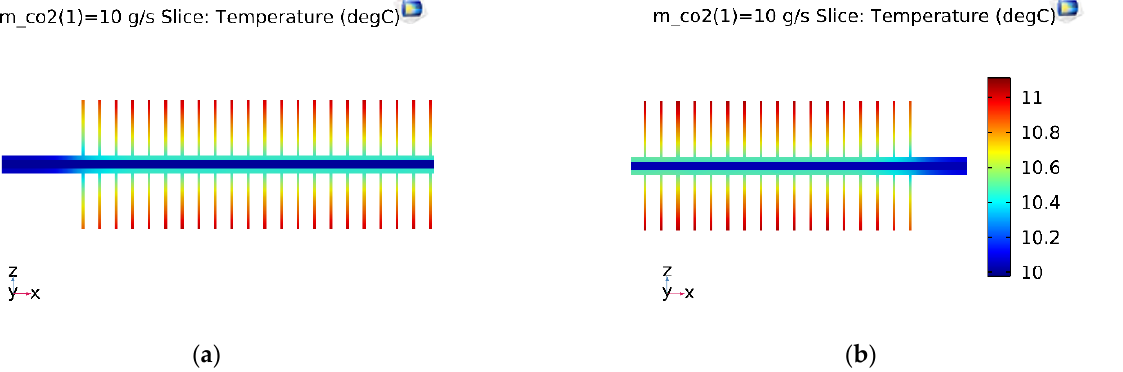
Figure 7. The temperature slice of the straight finned flat tube in the first pass. ( a ) Inlet; ( b ) Outlet.